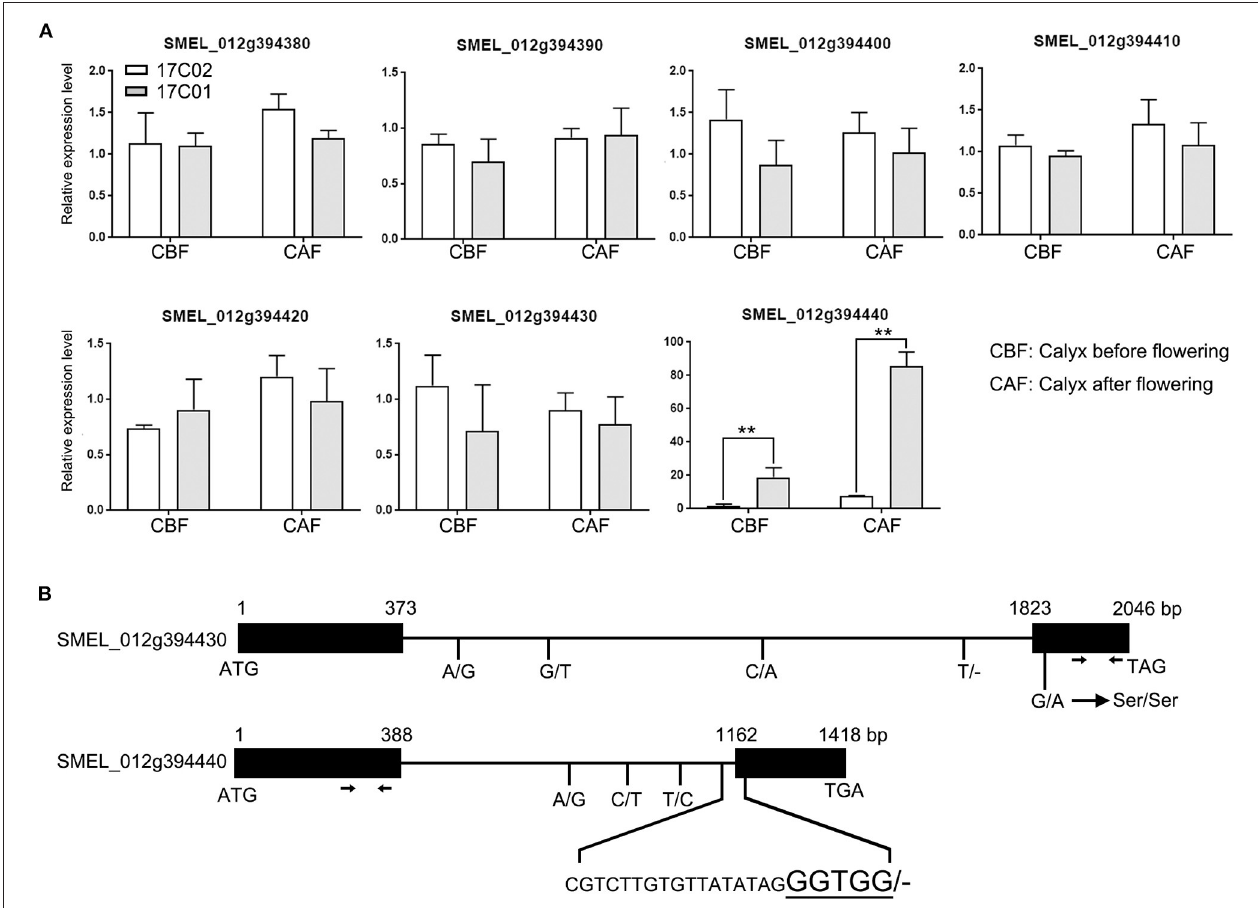
FIGURE 5 | The expression analysis and sequence varieties of candidate genes related to the development of prickle in eggplant. (A) The expression profiles of seven candidate genes in the region of qPC.12 in calyx before and after flowering in 17C01 and 17C02. The expression level of one of the three biological replications in 17C02 calyx before flowering was defined as “1.” Values represent means ± SD ( n = 3) from three biological replicates. Statistical significance between the gene expressions in 17C01 calyx and 17C02 calyx before or after flowering was performed by a t -test: ** P < 0.01. (B) The genomic sequence varieties in SMEL_0112g394430 and SMEL_0112g394440 between 17C01 and 17C02. The black rectangles and lines were designated as exons and introns, respectively. The nucleotide numbers from ATG to stop codon, TGA or TAG, were marked on the top of rectangles in each gene. The single nucleotide variations and deletion/insertion variations, in which the nucleotides in 17C01 and 17C02 were placed on the left and right of the slash, respectively, were written below. The short bar represented that there was no nucleotide in this site. The four magnified characters were designated as the nucleotides in the predicted exon. The primers of SMEL_0112g394430 and SMEL_0112g394440 used in the real-time quantitative reverse transcription PCR (qRT-PCR) were marked with